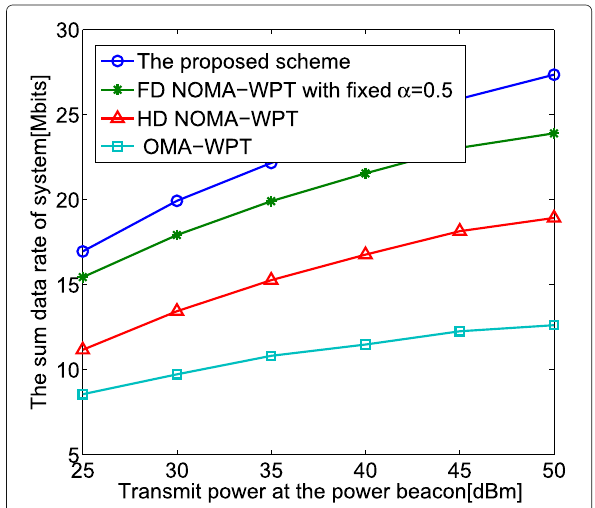
Fig. 5 The sum data rate of system versus transmit power at the power beacon